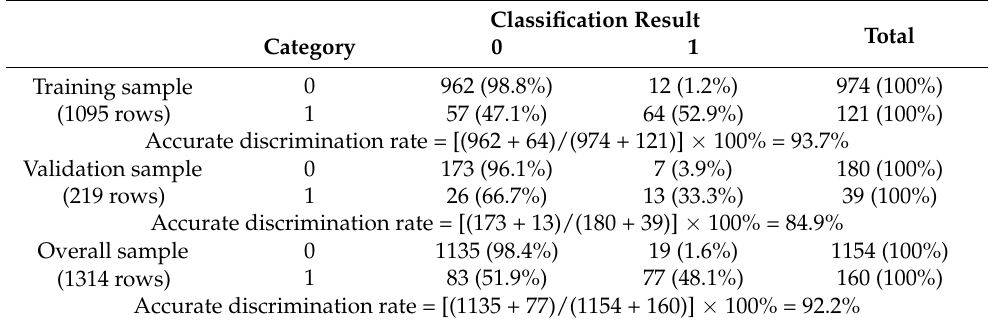
Table 15. Logistic-regression judgments.